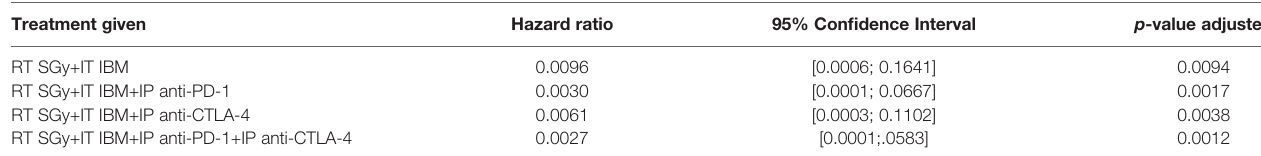
TABLE 1 | Hazard ratios for each treatment using RT+IBM and additional checkpoint inhibitors compared with control adjusted to the initial pretreatment tumor size. Treatment given